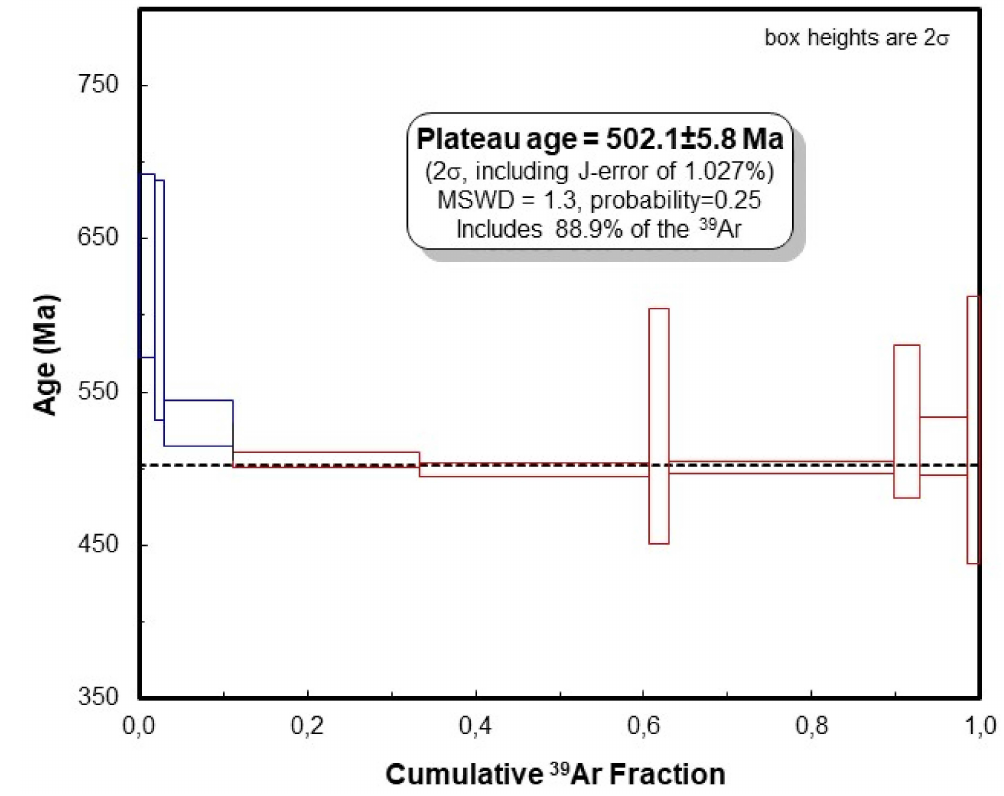
Figure 8. 40 Ar / 39 Ar apparent age spectra of the coarse-grained muscovite sample. Laser energy increases from left to right. Vertical width of bars represents the 2 σ error and includes the error of the J-value. Steps 4–10 are used for calculation of the plateau